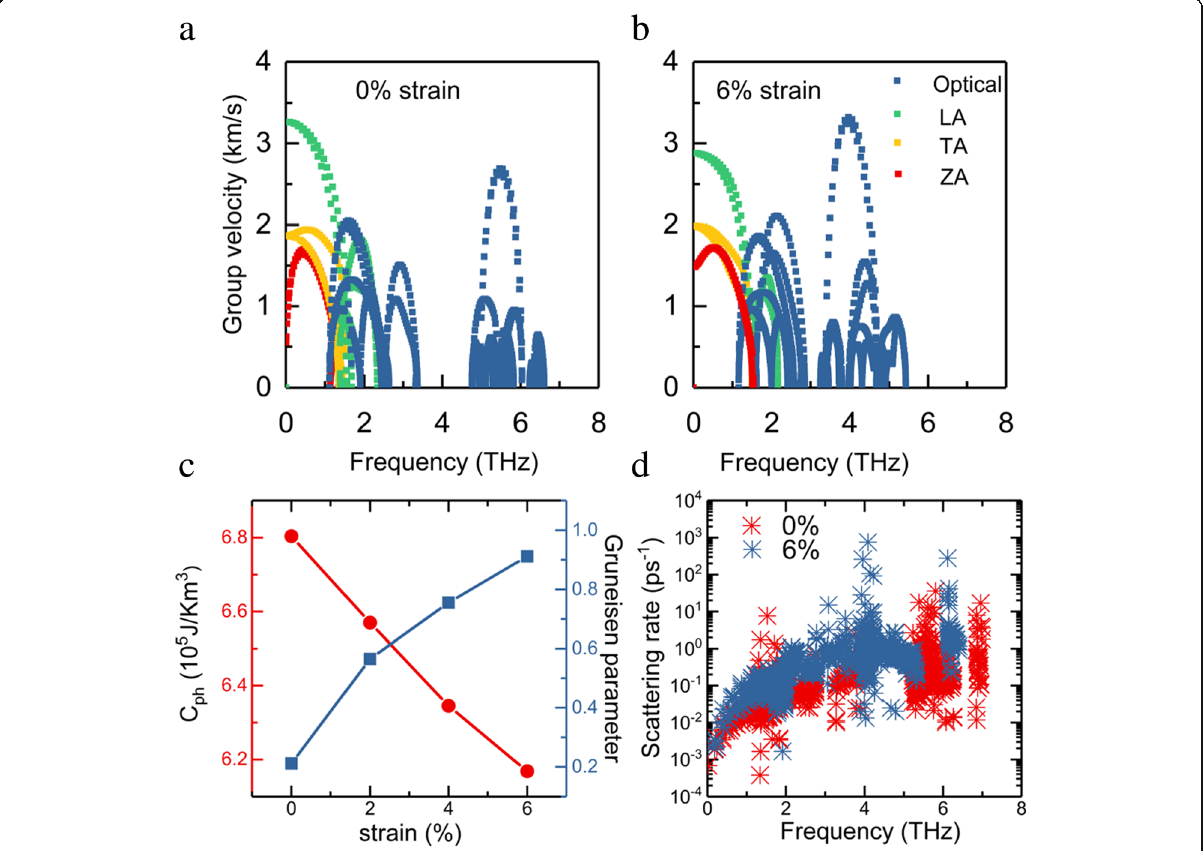
Fig. 5 The contribution of ZA, TA, LA, and optical modes to the group velocity of monolayer InSe for ( a ) unstrained and ( b ) 6% strained systems. c Phonon heat capacity ( C ph ) and Gruneisen parameter as a function of strain at 300 K. d Phonon scattering rate of unstrained and 6% strained monolayer InSe as a function of